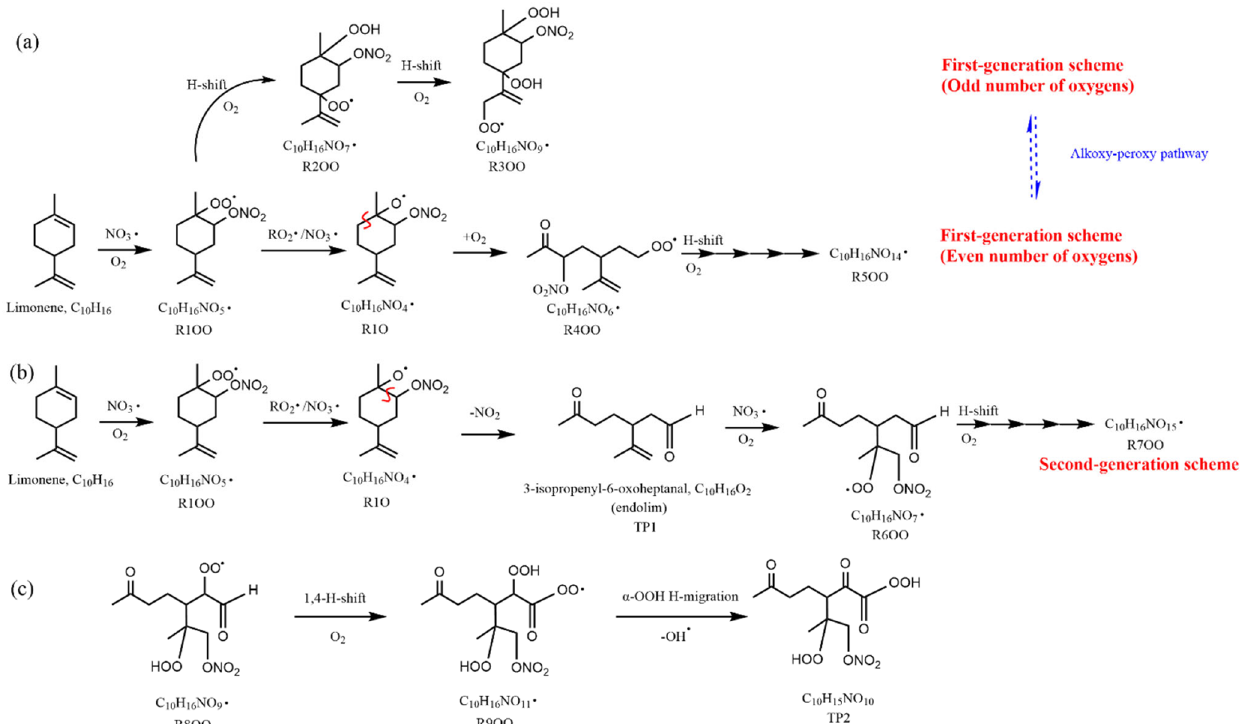
Scheme 1. Illustrative scheme for HOM formation in the limonene + NO 3 reaction. (a) Example formation pathways leading to first-